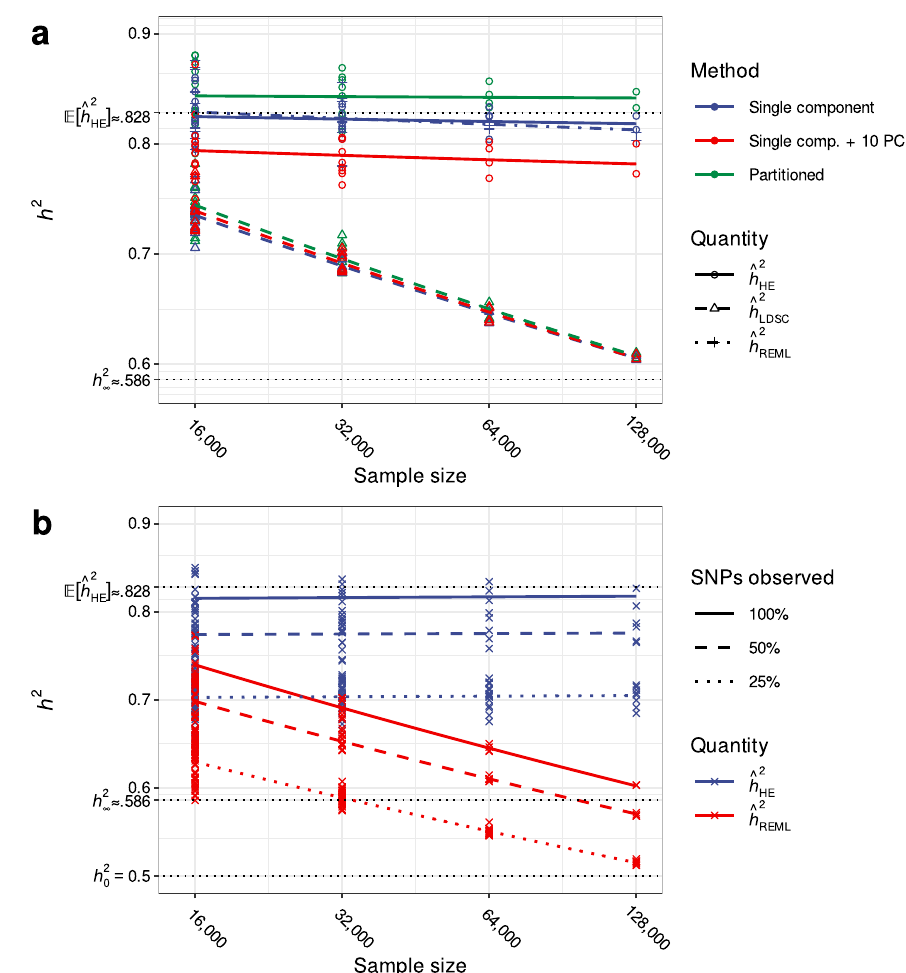
Fig. 3 Naïve approaches to addressing AM induced bias and the impact of missing data. a Simulations employing the same parameters described in Fig. 1 demonstrate that neither partitioned nor principal component adjusted approaches mitigate the impact of AM on HE ( ^ h 2 estimates. Additionally, simulations con fi rm that LDSC is subject to equivalent biases. Single component: standard single genomic variance component models. Single comp. + 10 PCs: included the fi rst ten within-sample PCs as covariates. Partitioned: included four annotation-based variance components generated by median splits of within-sample minor allele frequencies and LD scores. b Simulations demonstrate that conclusions regarding estimator bias do not change when some of the in fl uence of causal variants is not captured by measured SNPs. Simulations employed the same parameters as above except that 0, 50, or 75% of randomly selected SNPs (both causal and non-causal) were dropped. As expected, estimates were attenuated when SNPs were dropped but overall patterns remained